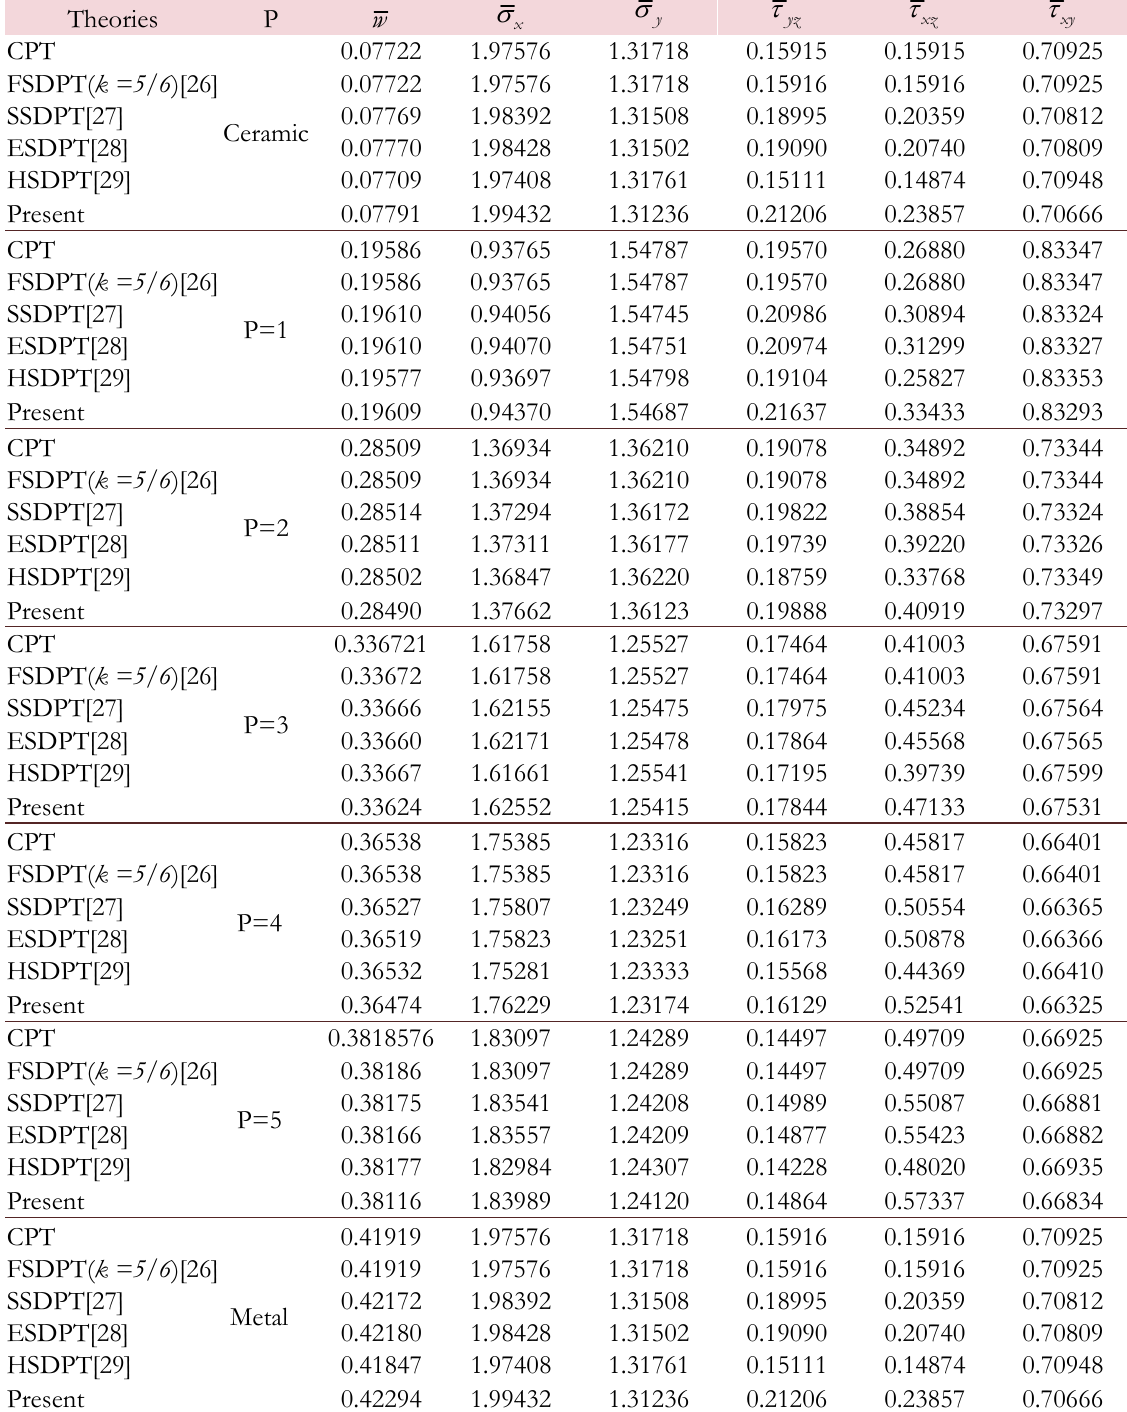
Table. 2: Comparative study of deflections and stress non-dimensional of sandwich plate FGM for different volume fraction